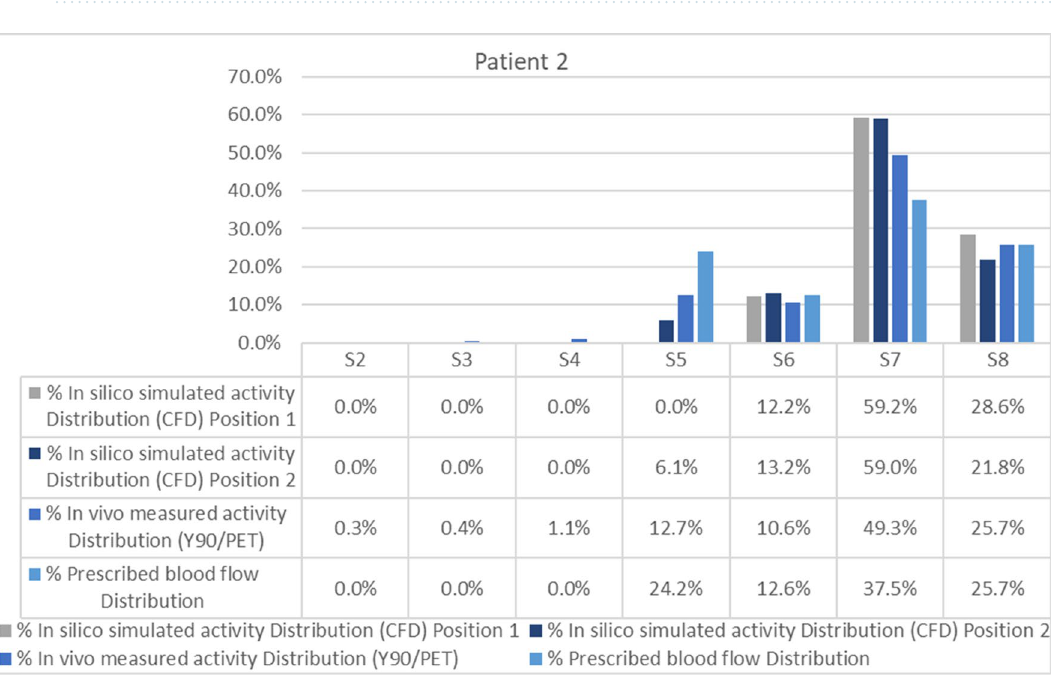
Figure 6. Segment-to-segment calculated activity distribution (CFD), measured activity distribution ( 90 Y/PET), and prescribed blood flow split for Patient